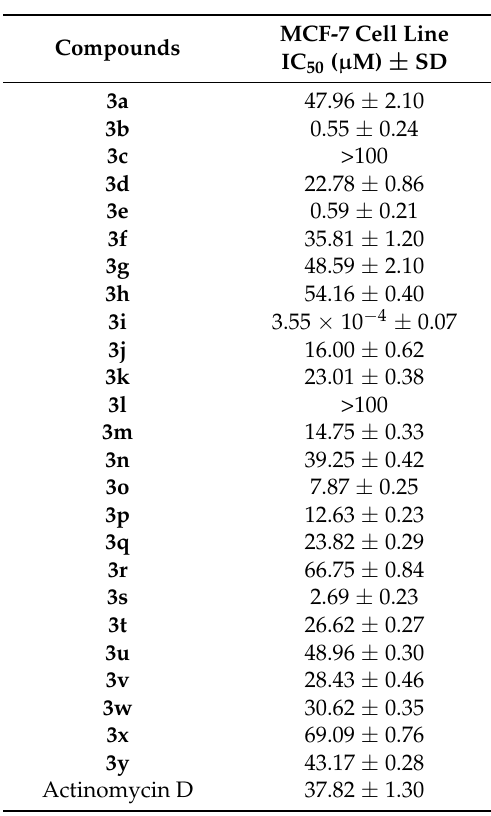
Table 2. Cytotoxic effects of 3a – y against MCF-7 cell line. The results are presented as IC 50 ( µ M) ± standard deviation (SD) from three individual